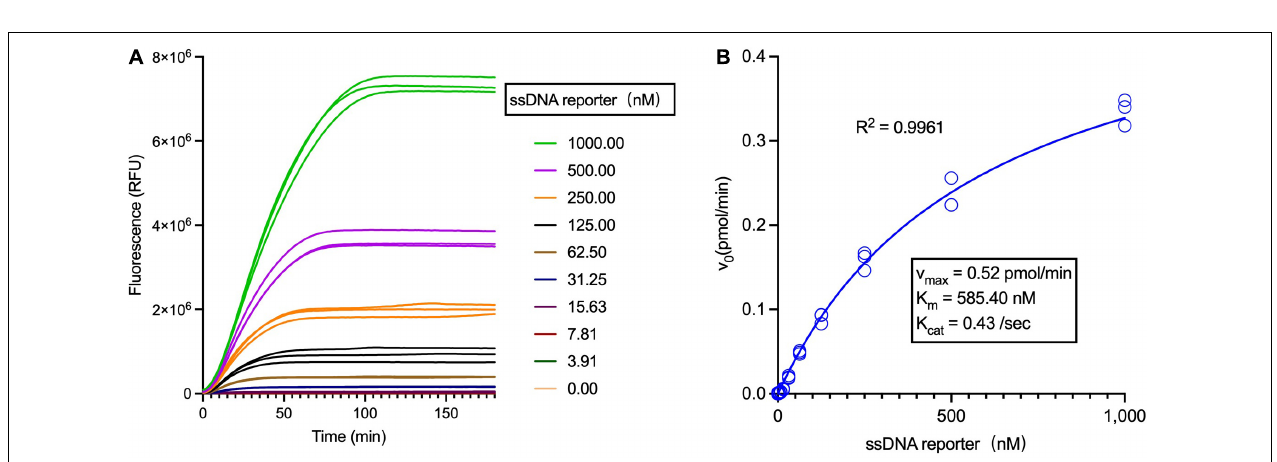
FIGURE 4 | Analysis of the LbCas12a enzymatic kinetics. (A) Fluorescent curves of the Cas12a trans -cleavage reactions using different concentrations of the ssDNA reporter. (B) Analysis of the Michaelis-Menten constants of LbCas12a (Tolo Biotech.), employing 1 nM Cas12a and varied concentrations of ssDNA reporters.